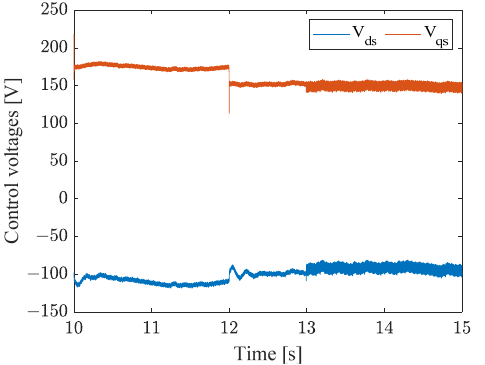
Figure 13. dq control voltages with FLC in healthy and faulty modes.